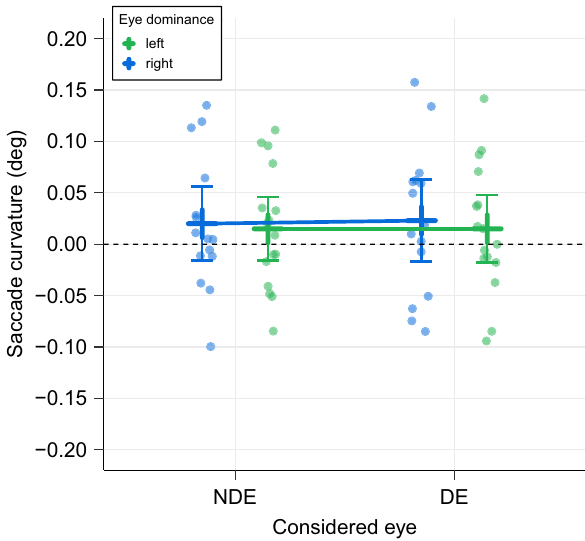
Figure 5. Saccade trajectory curvature in Binocular/Two Distractors condition. For each participant and for saccades initiated before the toward/away switch latency (215 ms, red vertical line on Fig. 3), the saccade curvature values when two distractors were presented was plotted as a function of the considered eye. Positive values correspond to a curvature toward the distractor placed in the contralateral hemifield. Error bars represent 95% confidence intervals. The linear model approach shows a statistically significant difference from zero (p < 0.05) for the whole population. See text for further details.